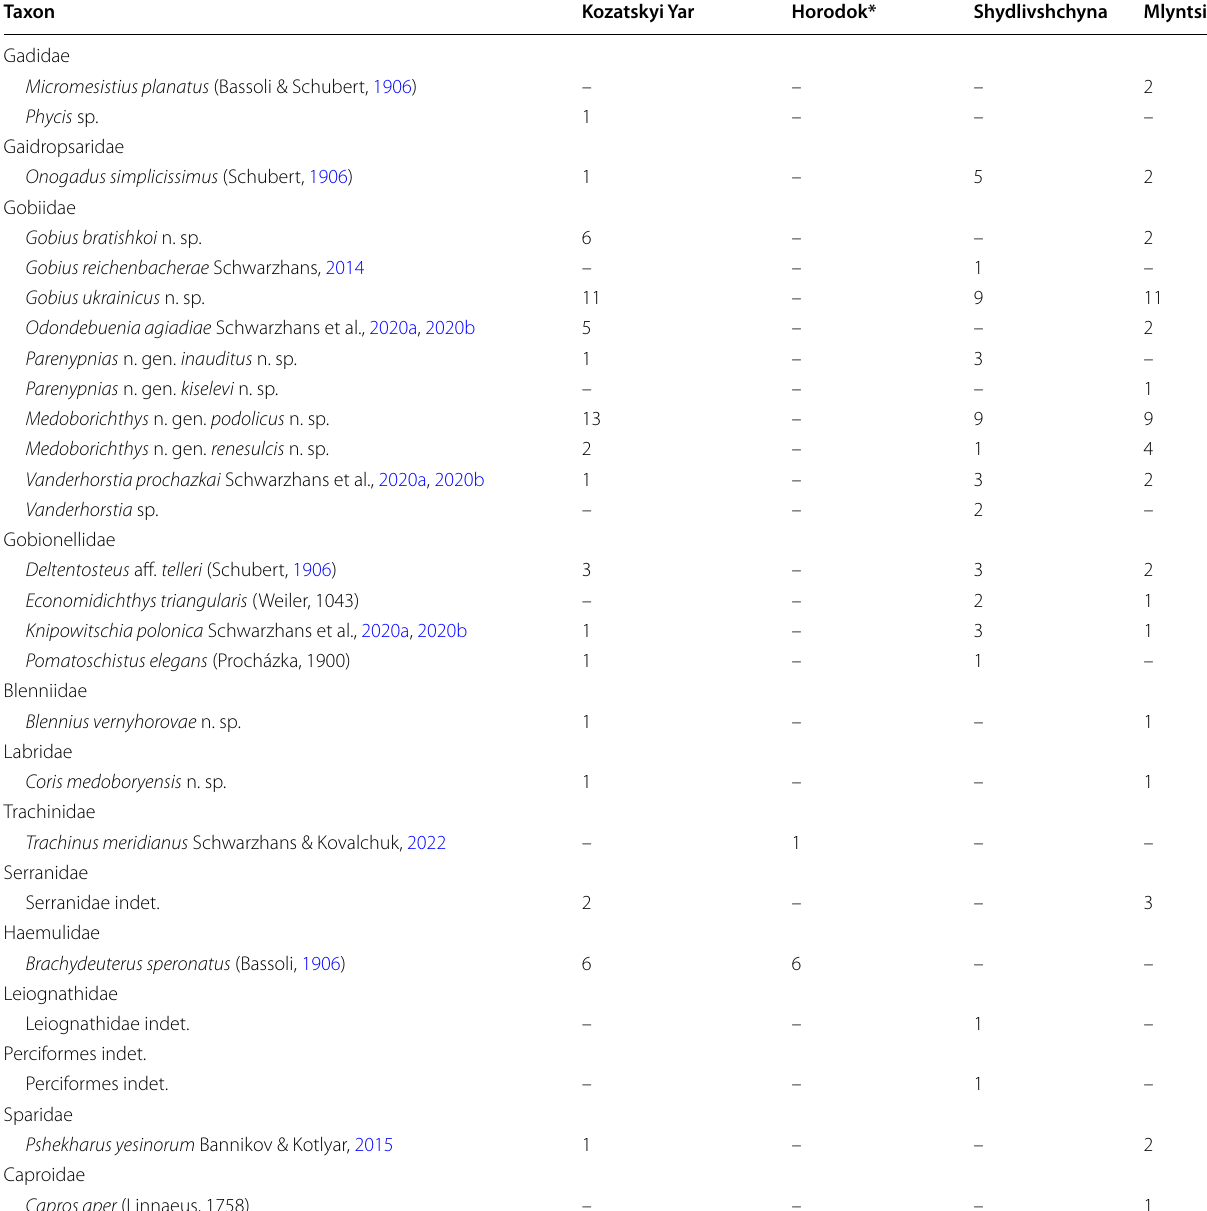
Table 2 List of otolith-based species from the three localities studied here and Horodok* published by Schwarzhans and Kovalchuk